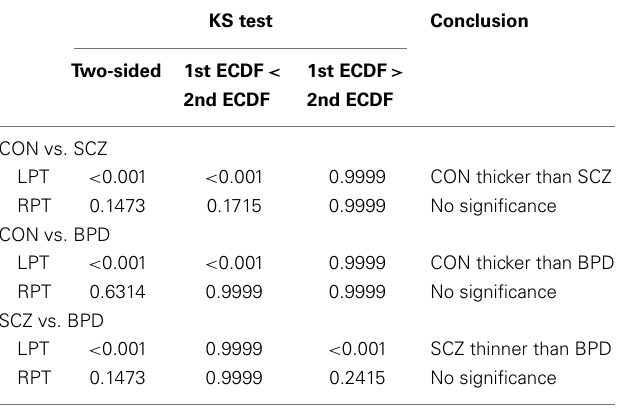
Table 2 | Kolmogorov–Smirnov (KS) test for ECDF comparisons of pooled LCDM distances in diagnostic groups .